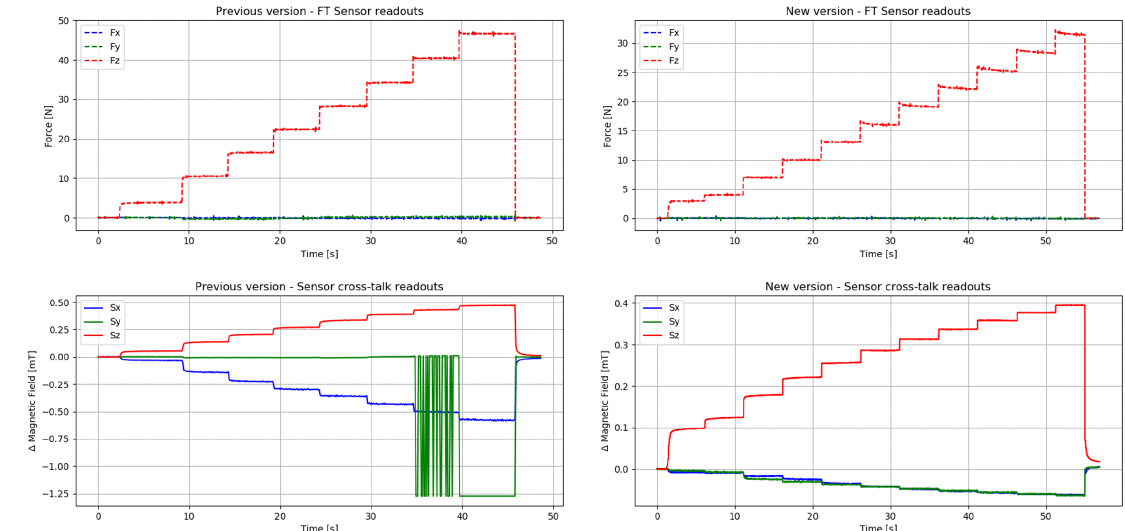
Figure 7. Crosstalk raw data comparison. Left: previous version of the sensor with high crosstalk values and saturation. Right: new version of the sensor with greatly reduced crosstalk values.